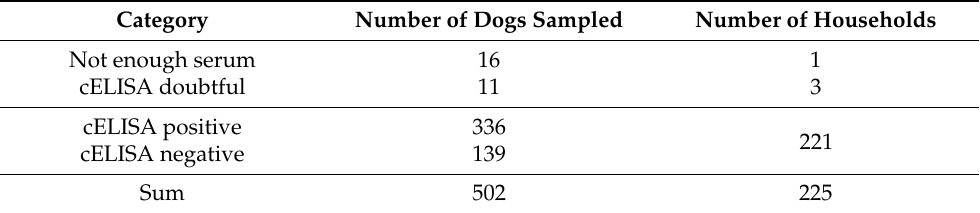
Table 1. Number of households visited with dogs